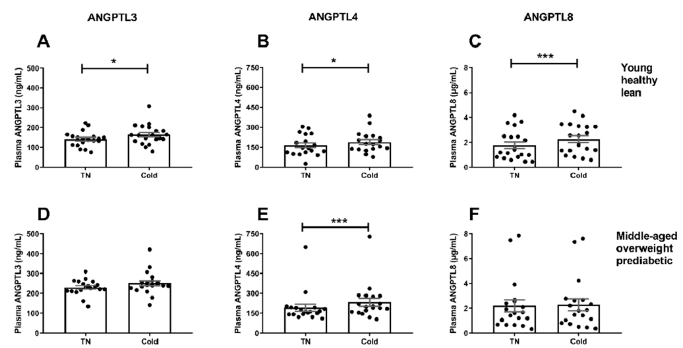
Figure 1. Effect of cold exposure on plasma ANGPTL3, ANGPTL4, and ANGPTL8 levels in young, healthy, lean men (A–C) and middle-aged men with overweight and prediabetes (D–F) . Data are mean ± SEM. *** p < 0.001, * p < 0.05 cold vs. thermoneutrality (TN).